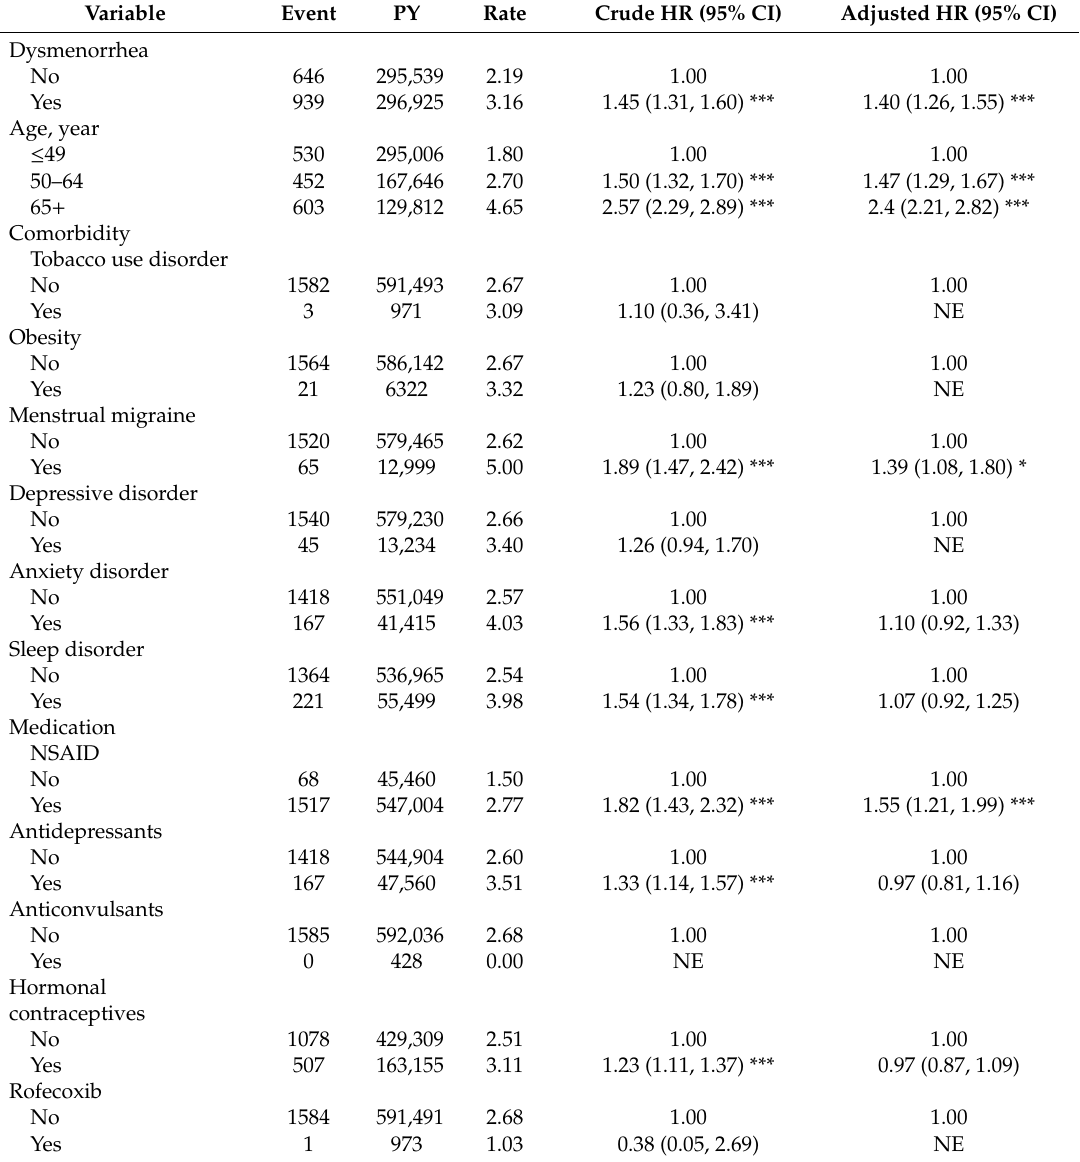
Table 2. Incidence and hazard ratio for the risk factors of